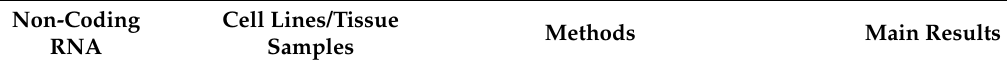
Table 1. Alterations of non-coding RNAs in